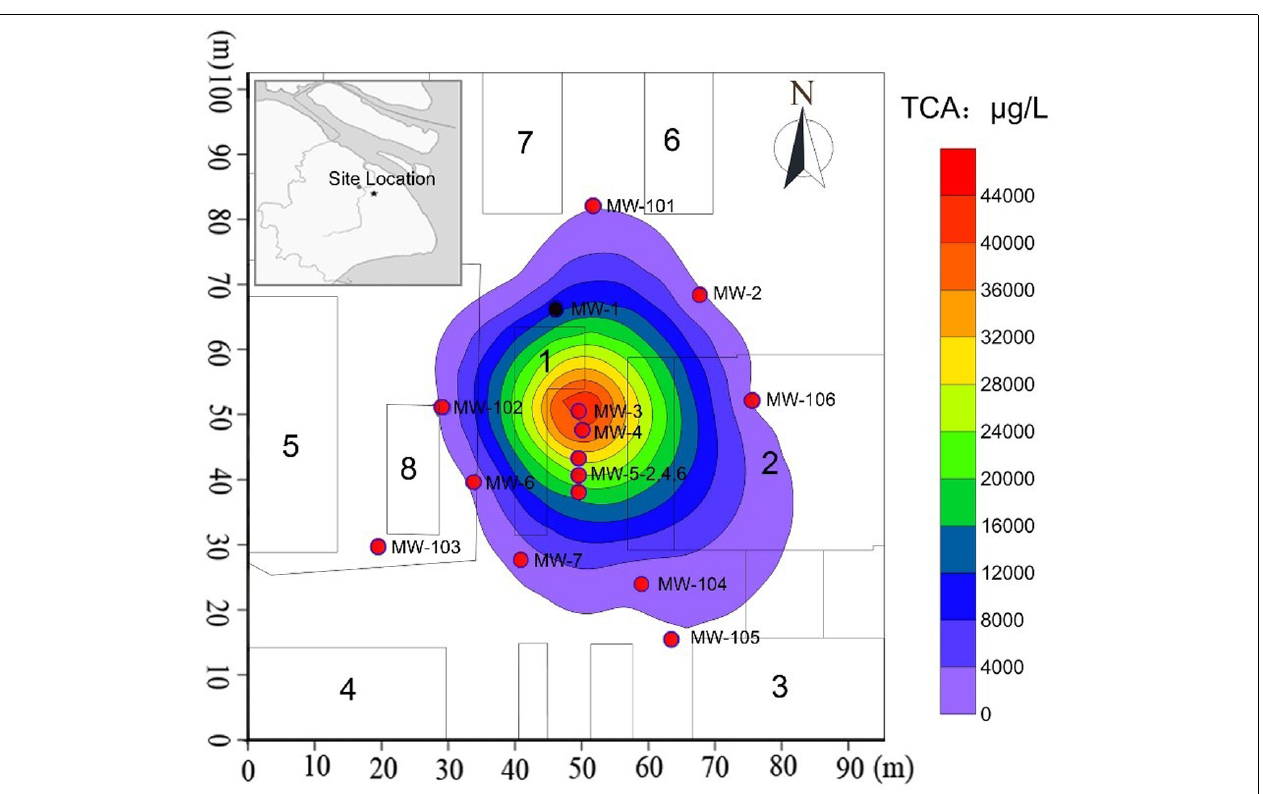
FIGURE 1 | Details of TCA contamination plume and monitoring network in Area-4 site. The number 1 is the chemical warehouse; the number 2–6 are workshop; the number 7–8 are product warehouses; MW-1 to MW-7 and MW-101 to MW-106 are the monitoring